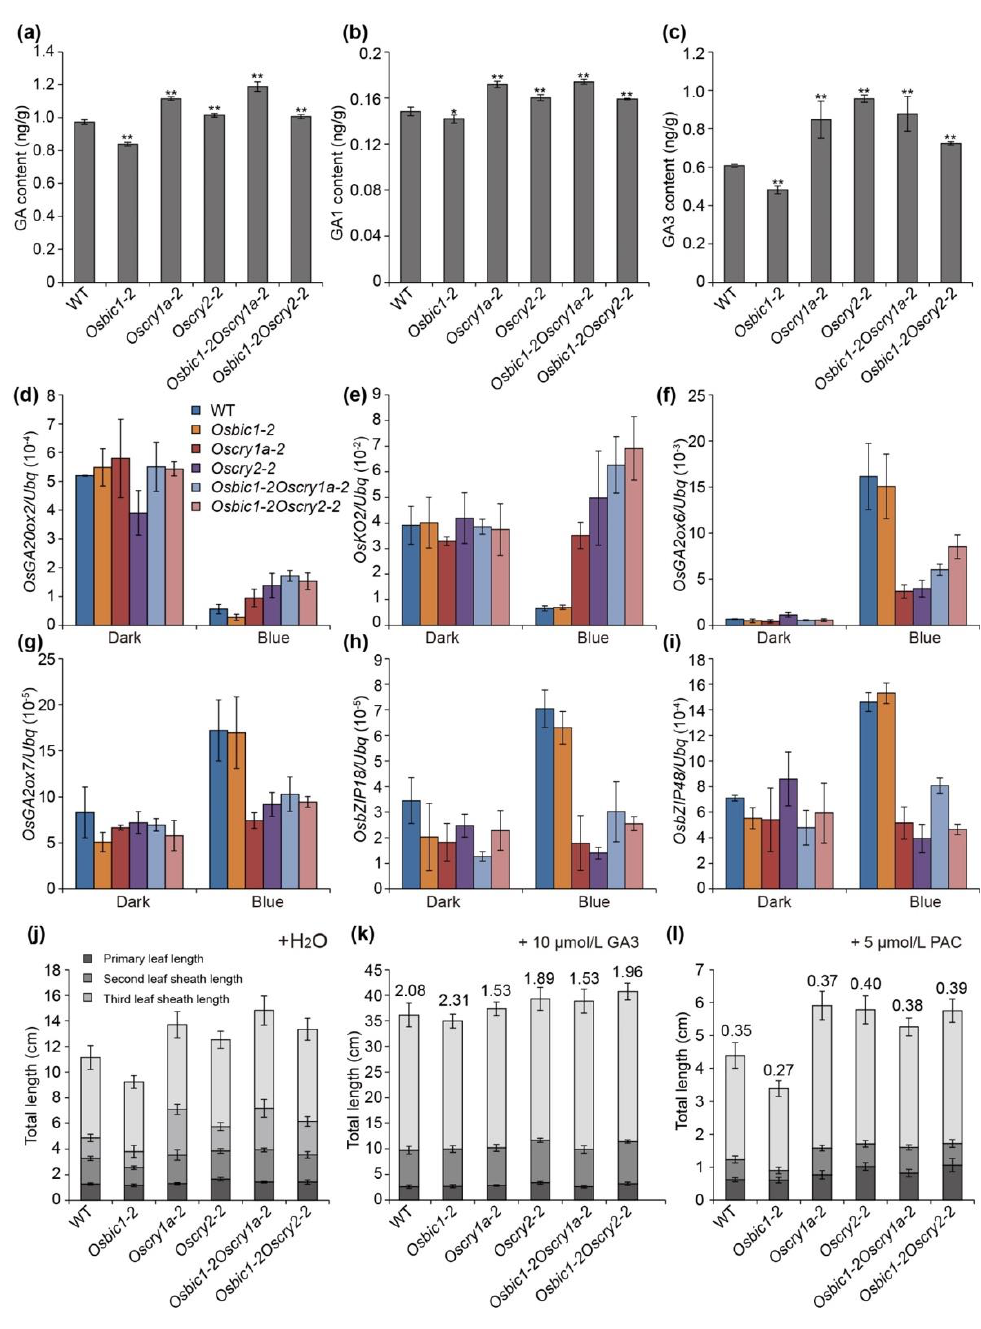
Figure 5. OsBIC1 and OsCRYs regulated the gibberellic acid (GA)-responsive gene expression under blue light conditions. ( a – c ) The GA, GA1, and GA3 content of seven-day-old seedlings grown in continuous blue light conditions (25 µmol m −2 s −1 ). Comparisons were performed by Student’s t -tests (* p < 0.05, ** p < 0.01). ( d – i ) Comparisons of transcription levels of GA-responsive gene using qRT-PCR between WT and each indicated mutants. The relative expression levels (REL) are shown as means ± s.d. ( n = 3). Ubiquitin ( Ubq ) was used as an internal control, and the REL of the WT sample in the dark was arbitrarily set to 1. ( j – l ) Comparisons of leaf sheath length between WT and each indicated mutants in response to GA3 or Paclobutrazol (PAC). The leaf sheath length analyses of 14 days old seedlings grown under continuous 35 µmol m −2 s −1 blue light. The number on the column indicated sensitivity to GA3 or PAC. Each number on the plot represented leaf sheath elongation ratio, which was equal to leaf sheath length under GA3 or PAC treatments divided by leaf sheath length treated with water.